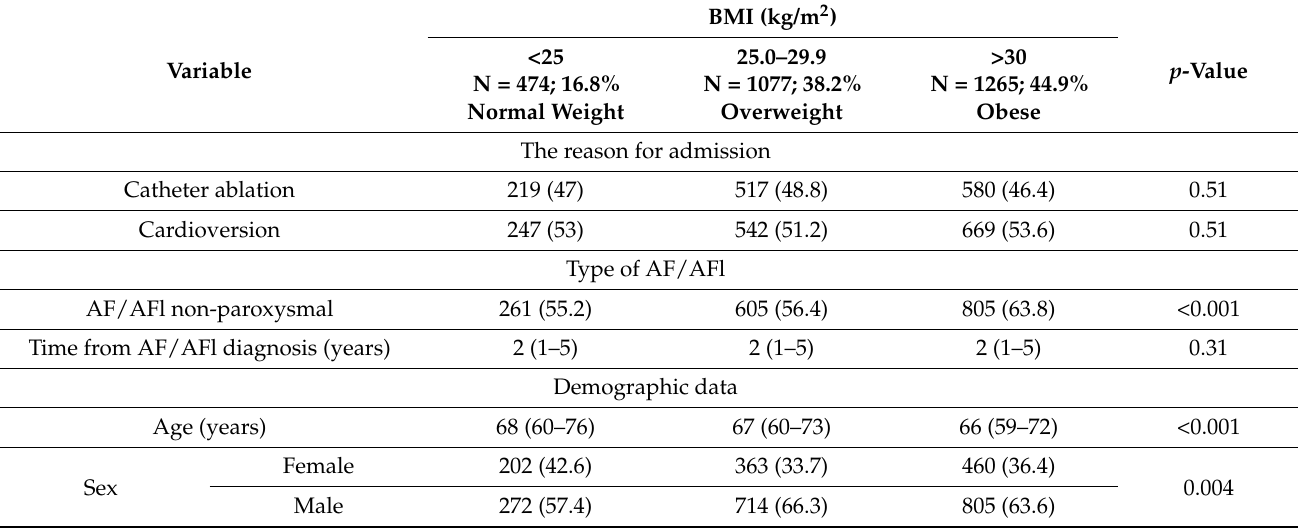
Table 1. Characteristics of the study group according to body mass index